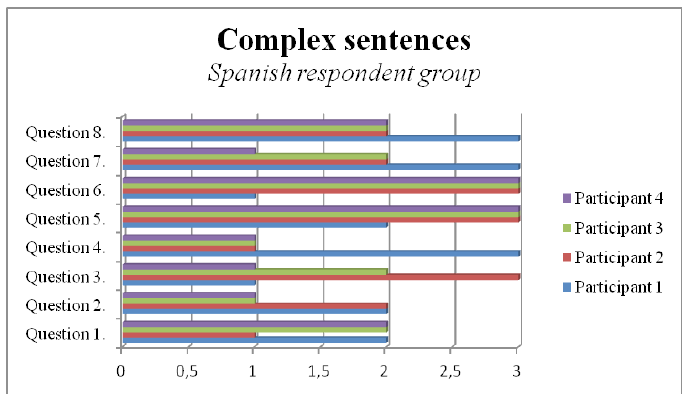
Graphic 12: Complex sentences - English respondent group.